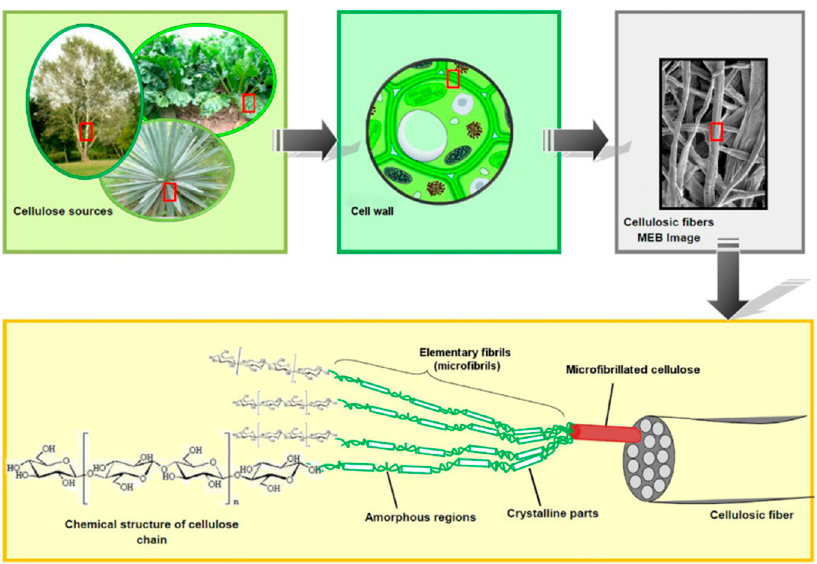
Figure 1. Deconstruction of chemical structure of cellulose sources. Reprinted from reference [48] with permission from Elsevier.